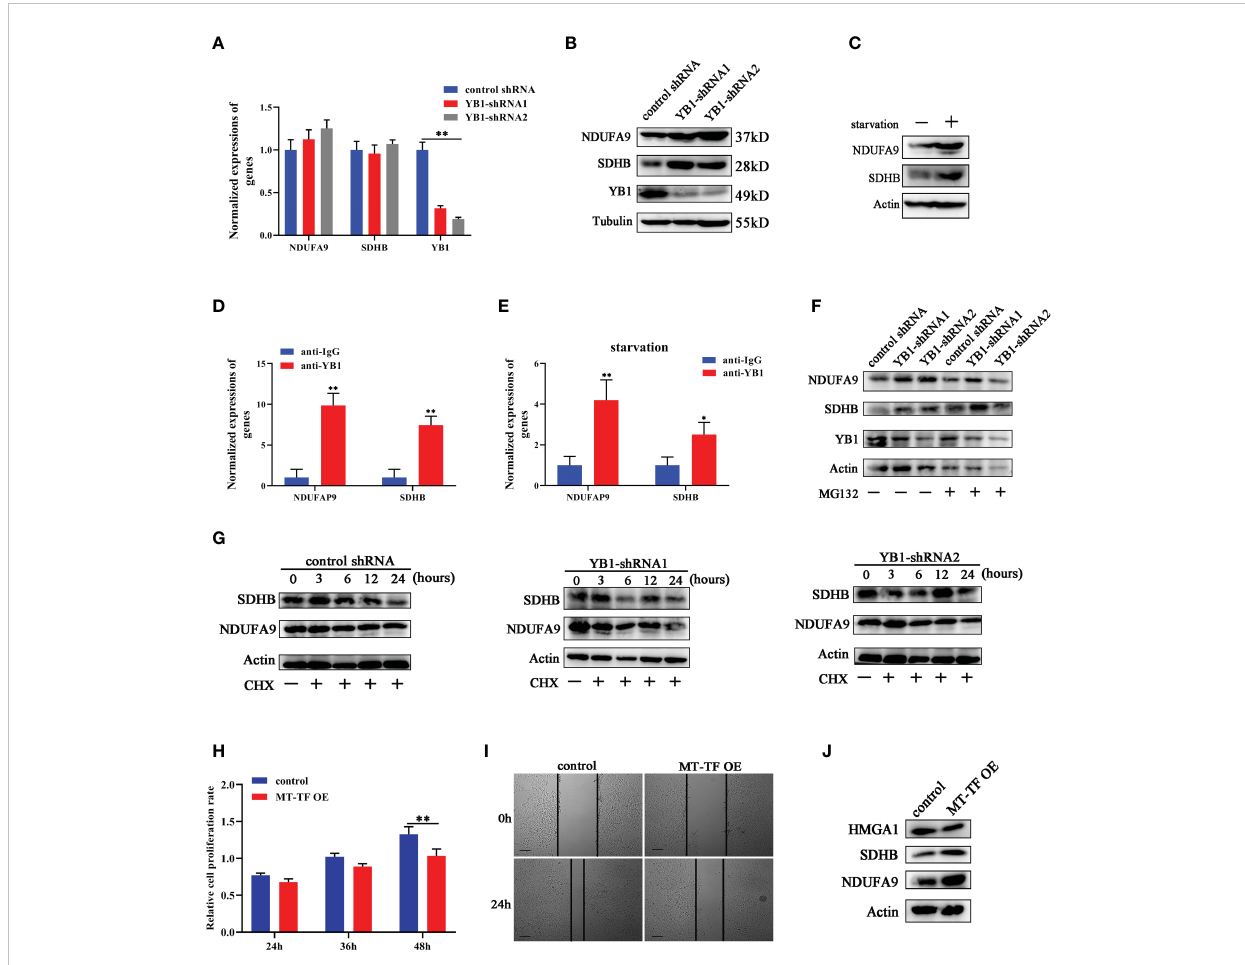
FIGURE 6 YB1 inhibited OXPHOS gene translation. (A) The in fl uence of YB1 knockdown on mitochondrial oxidative phosphorylation gene (NDUFA9 and SDHB) expressions at the mRNA level. n = 3, **p < 0.01. (B) YB1 expression silence enhanced NDUFA9 and SDHB protein expressions through posttranscriptional regulation. (C) The in fl uence of starvation on DNUFA9 and SDHB expressions was investigated through Western blot. (D) YB1 directly interacted with OXPHOS mRNA. The interaction between YB1 protein and OXPHOS mRNA (NDUFA9 and SDHB) was demonstrated using